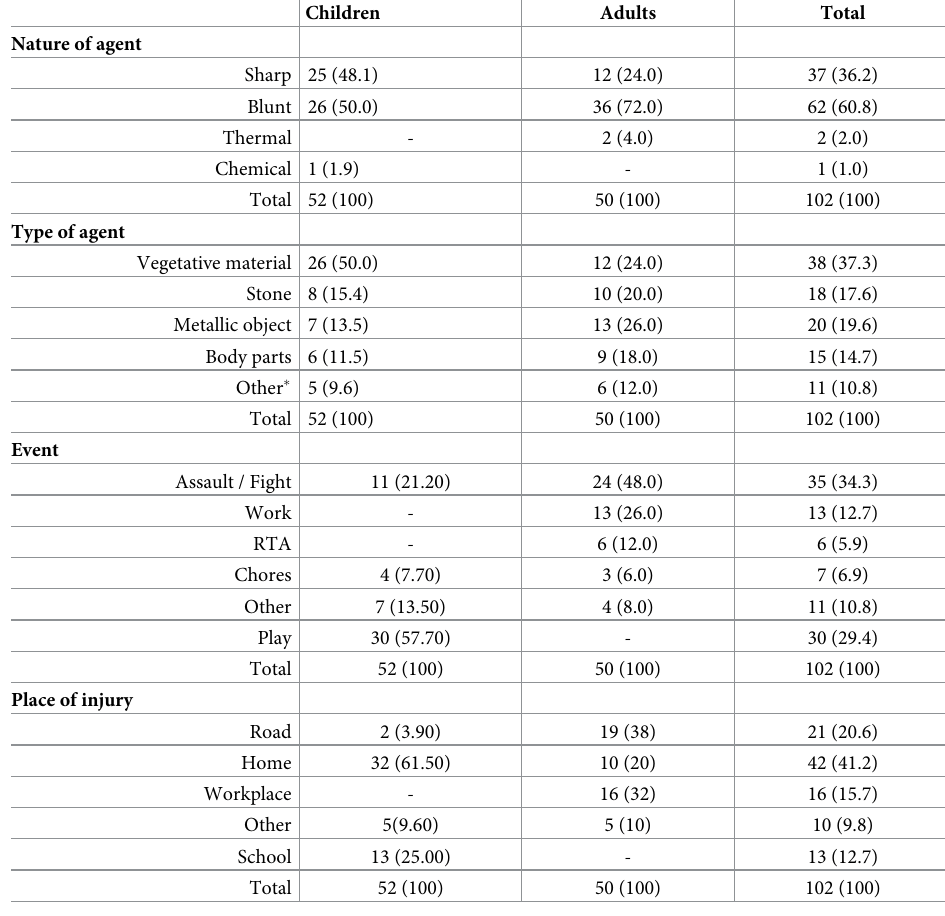
Table 2. Causative agents and context of ocular